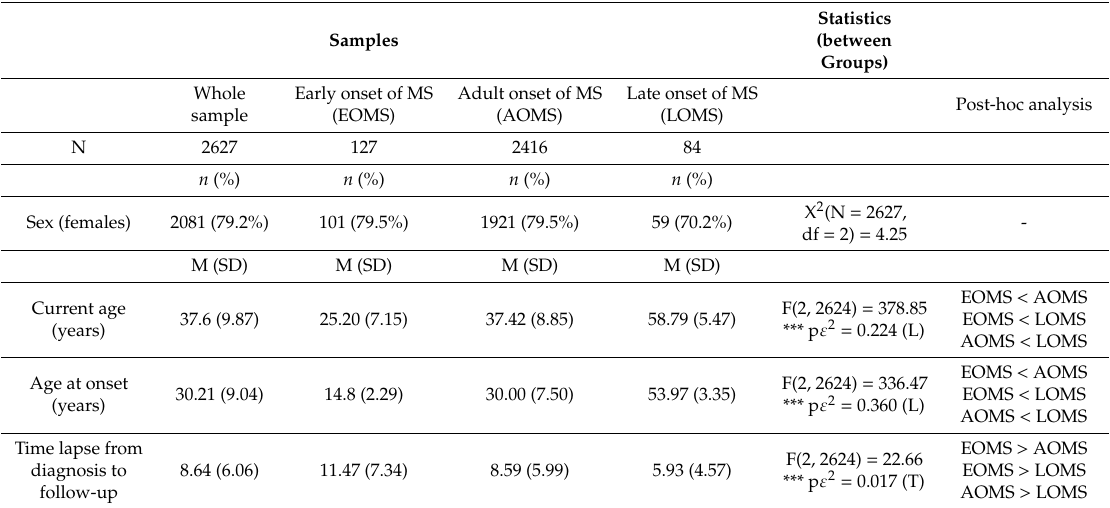
Table 1. Descriptive and inferential statistical indices of demographic characteristics between participants with early onset multiple sclerosis (EOMS), adult onset (AOMS) and late onset (LOMS).